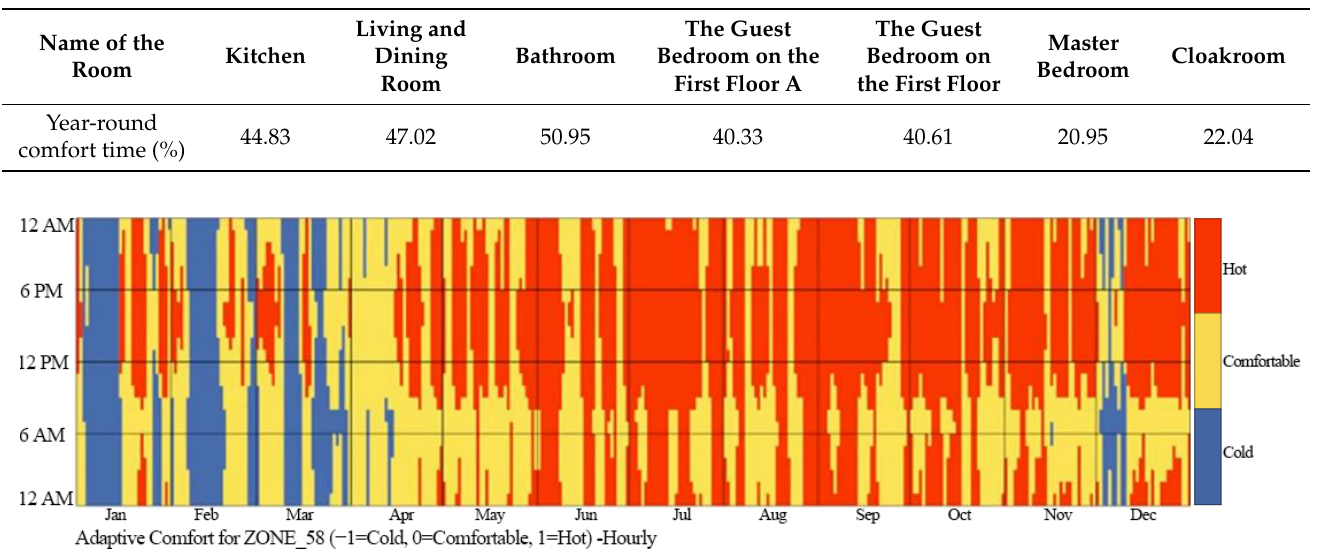
Table 9. The percentage of time the room is in thermal comfort throughout the year under natural ventilation conditions.